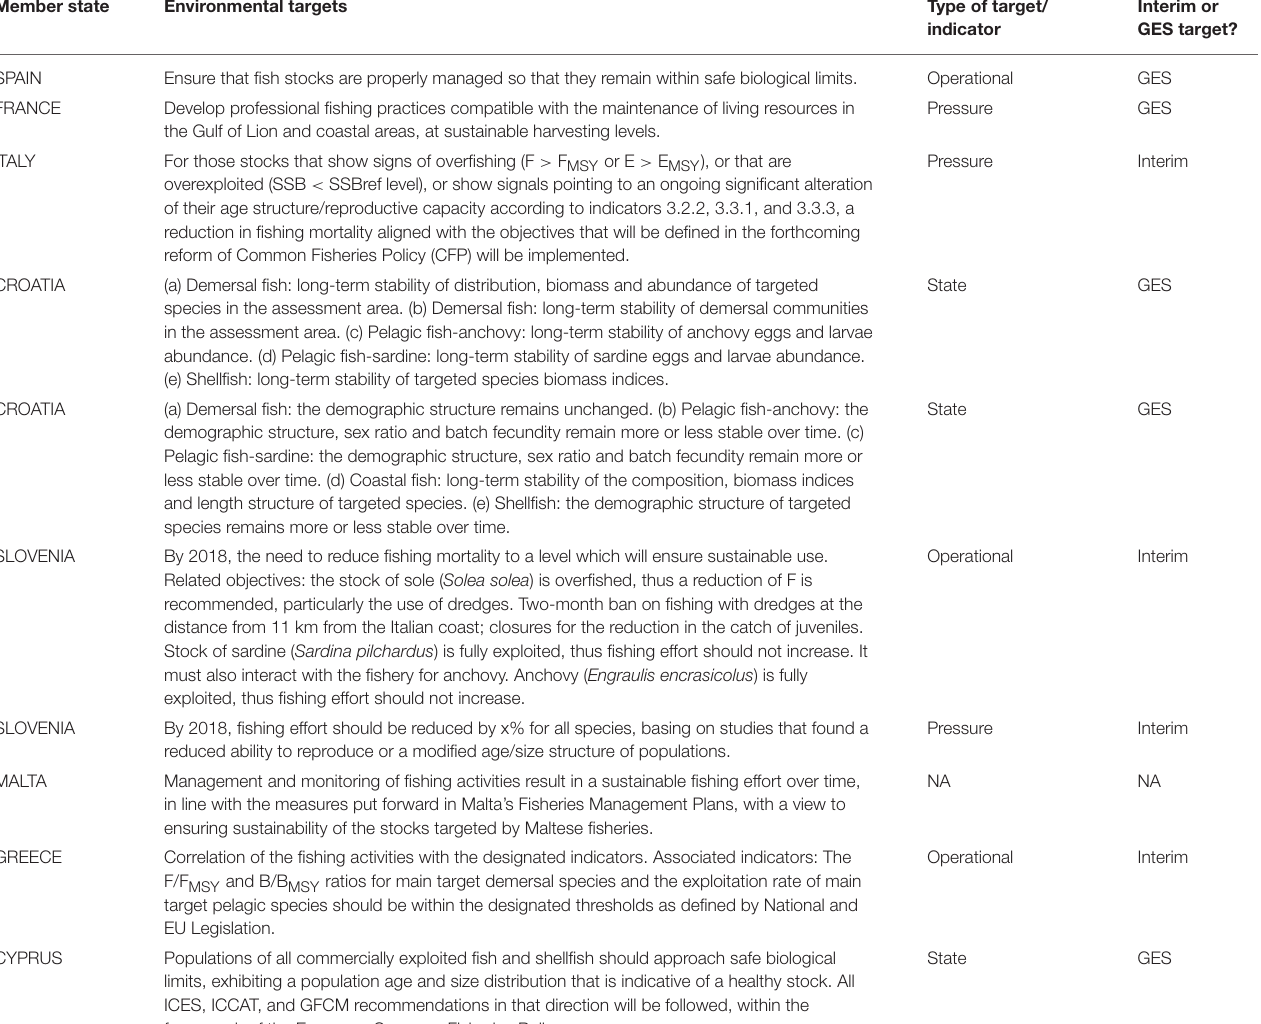
TABLE 5 | Selected list of environmental targets defined by Mediterranean EU member states in the early phases of MSFD implementation. Member